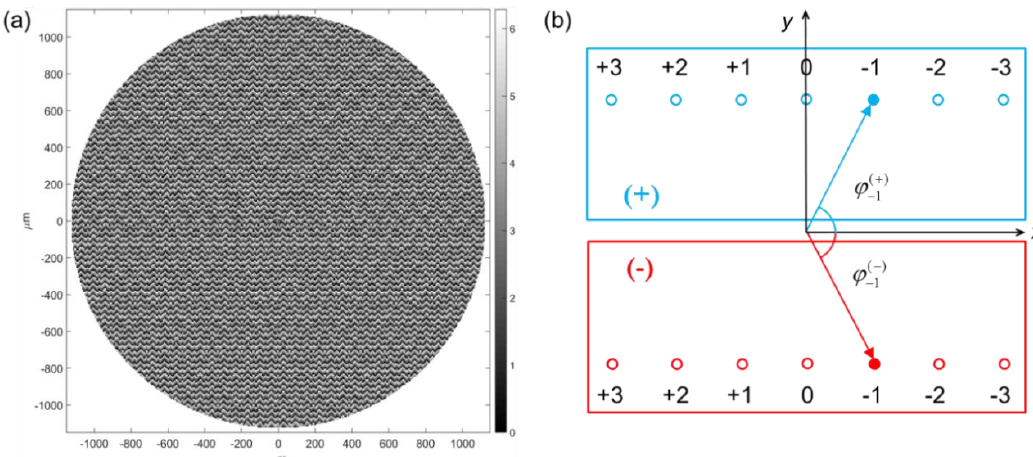
Figure 2. ( a ) Numerical phase pattern for the demultiplexing of optical beams with OAM in the set { − 3, − 2, − 1, 0, + 1, + 2, + 3} on a linear array. Pixel size: 6.250 µ m × 6.250 µ m. 16 phase levels. Radius length: 180 pixels. ( b ) Far-field channel scheme for the given OAM set and circular polarization states. Right-handed (in blue) and left-handed (in red) circularly-polarized OAM beams are detected in far field on two distinct linear arrays.